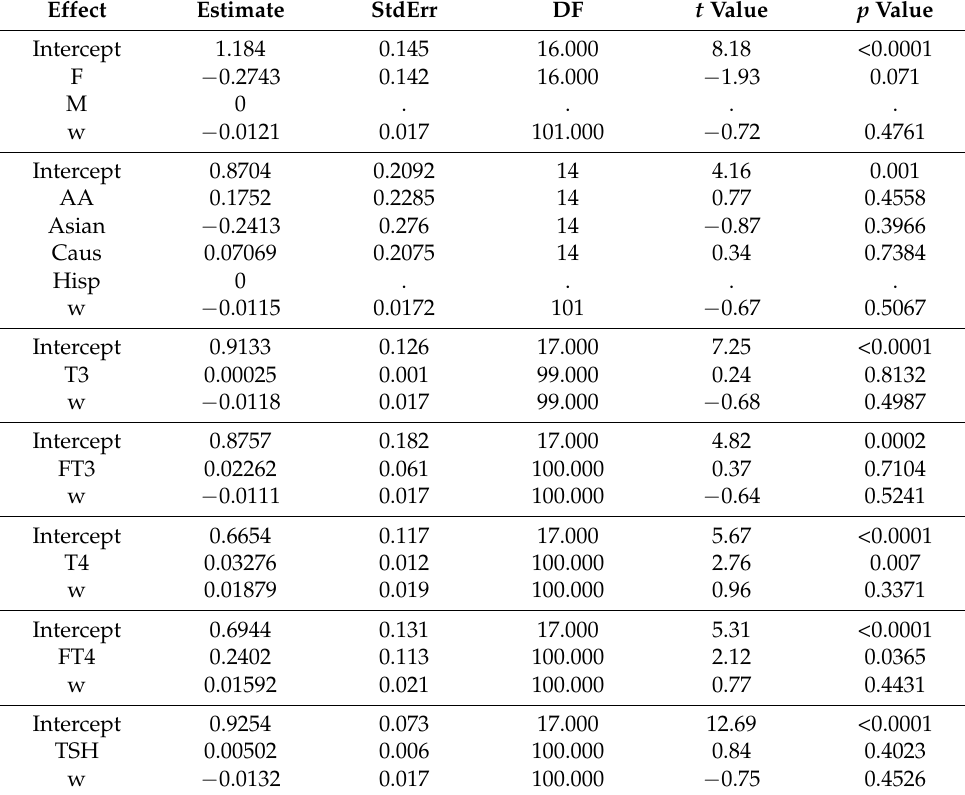
Table A3. Analysis of 3,5-T2 levels: Participants with hypothyroidism,